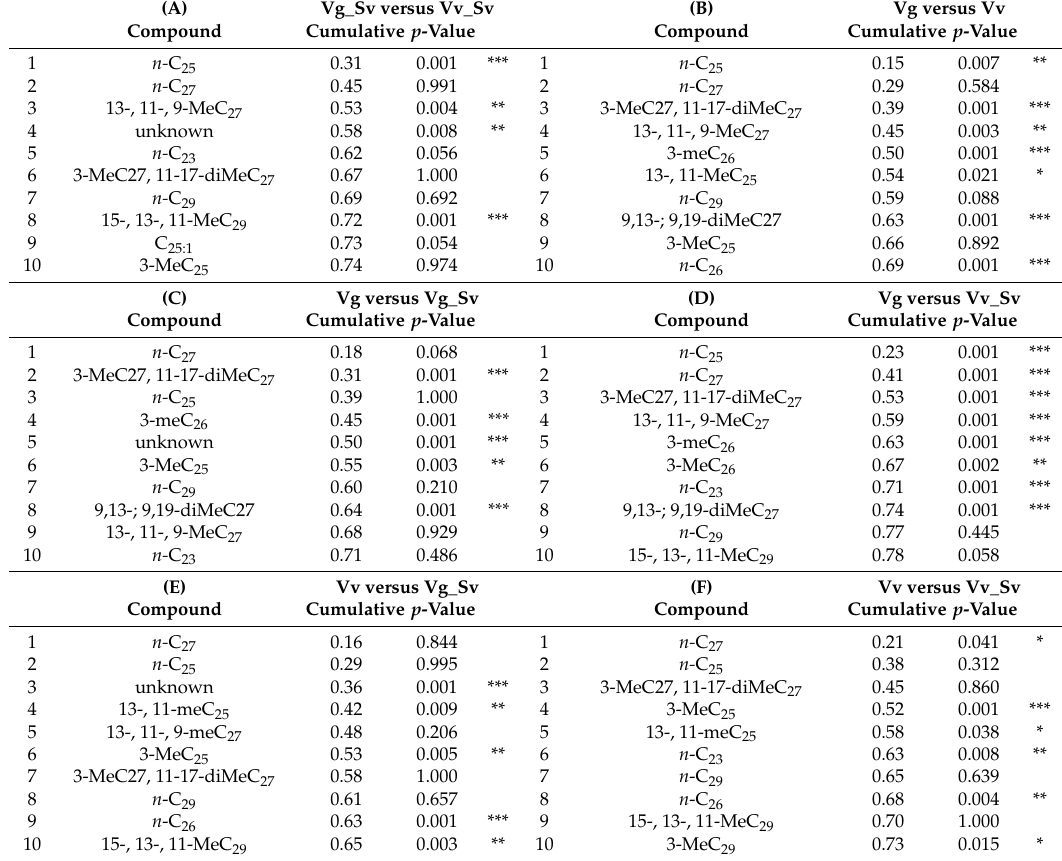
Table 3. Contribution of compounds discriminating the adult groups using SIMPER Bray–Curtis dissimilarities (999 permutations). (A) Vg_Sv versus Vv_Sv, (B) Vg versus Vv, (C) Vg